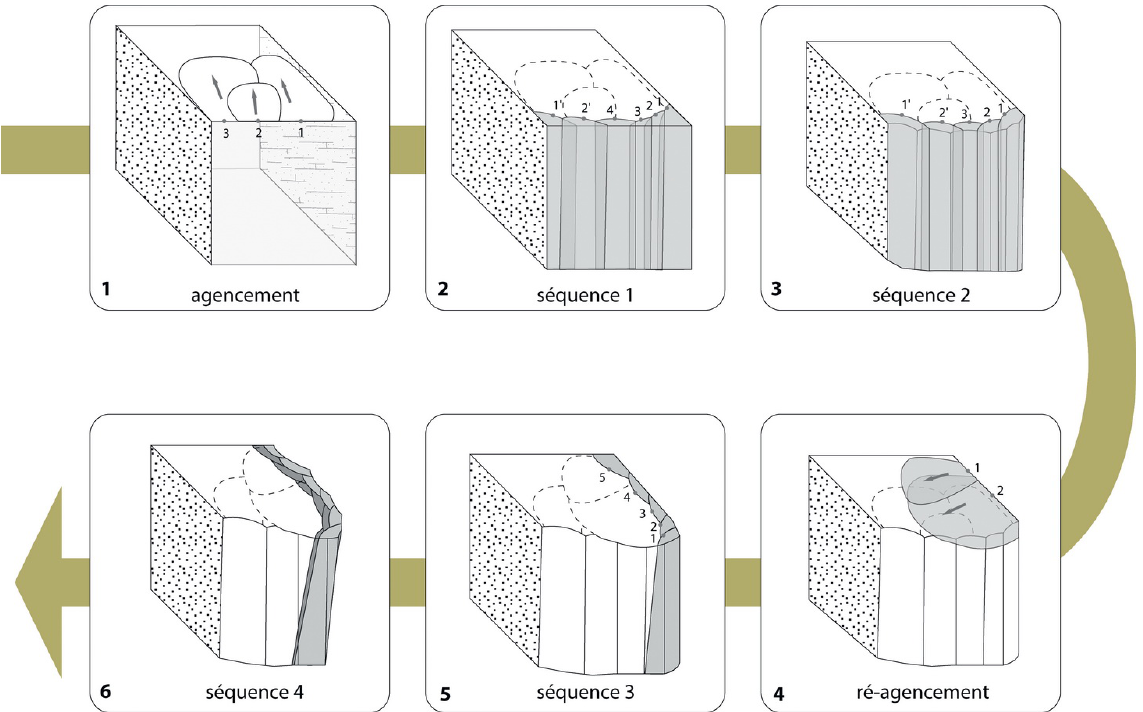
Figure 2. Schéma de débitage des séquences laminaires du second Mésolithique sur le site de l’Essart à Poitiers (Marchand 2009, 2014). Figure 2. Diagram of the laminar sequences of the second Mesolithic on the site of Essart near Poitiers (Marchand 2009,